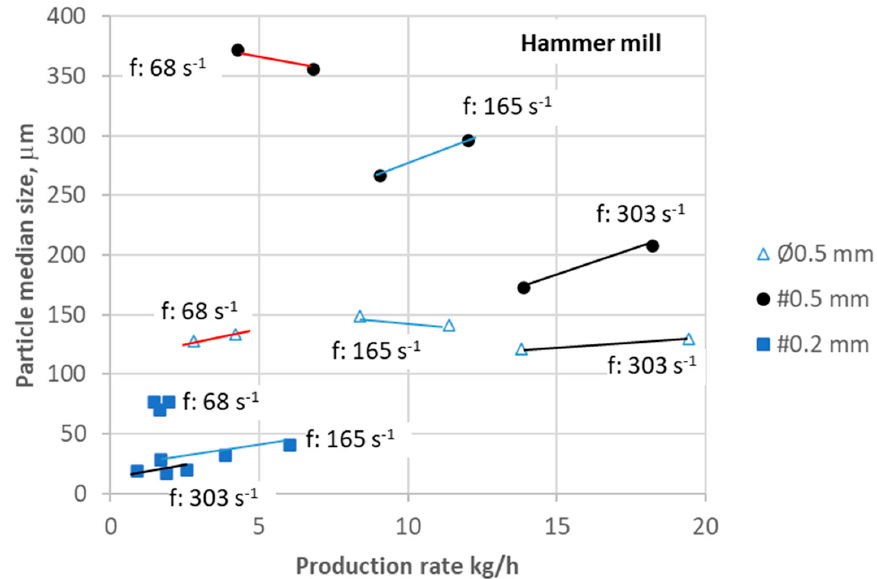
Figure 6. Dependence of particle size on the production rate at three levels of rotor frequency (f: 68 s − 1 , 165 s − 1 , and 303 s − 1 ) in hammer milling with different screen designs (Ø0.5 mm, #0.5 mm, and #0.2 mm).